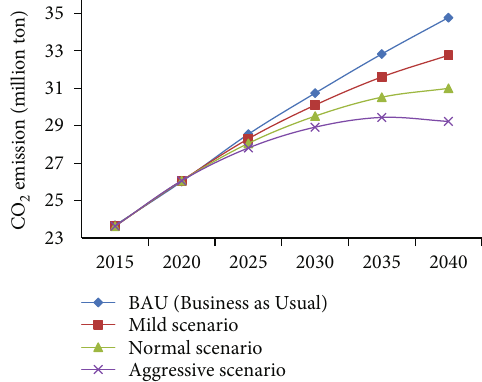
Figure 9: CO emission reduction in South Korea 2